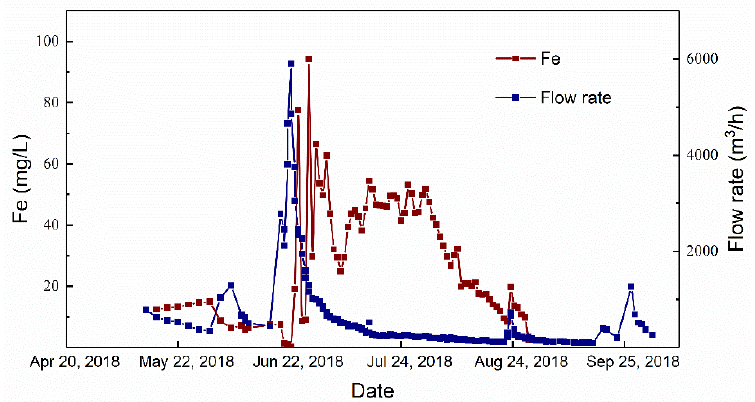
Figure 7. Changes of flow rate and concentration of Fe.